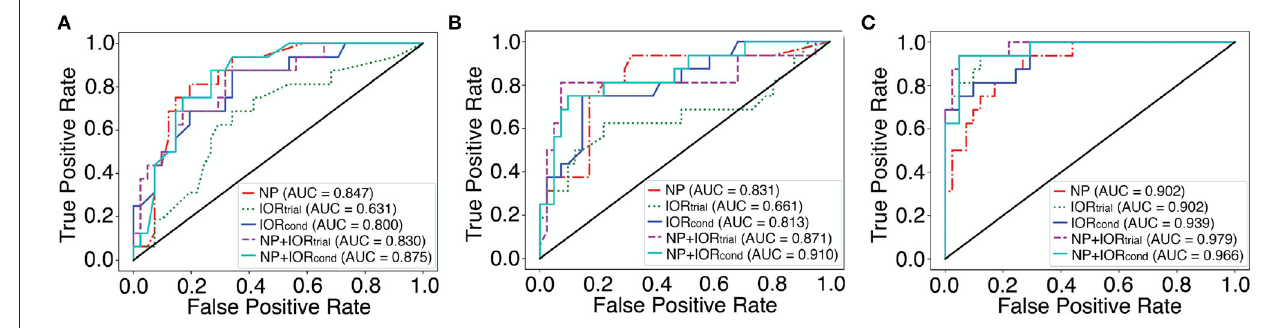
FIGURE 2 | The ROC curves for the best classifiers selected by the highest sensitivity for each dataset with traditional machine learning algorithms and with MLP. See Table 2 , Supplementary Tables 1-3 for the specific algorithms and parameters used for these “best” classifiers (shown in bold and italics font). (A) Traditional machine learning algorithms with all features and PCA (without and with SMOTE over-sampling). (B) Traditional machine learning algorithms with features selection (without and with SMOTE over-sampling). (C) The ROC curves for each dataset with MLP using the demographically comparable dataset. The AUC score is shown in the legend